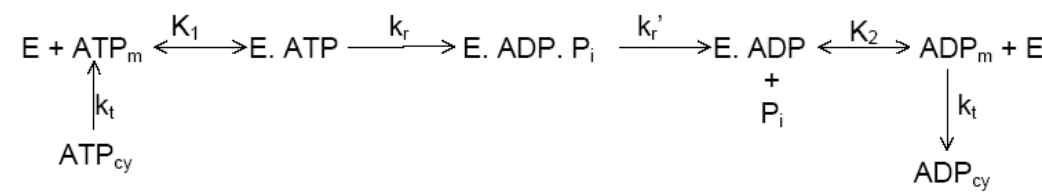
Figure 3. Kinetic Scheme for ATP Hydrolysis by F